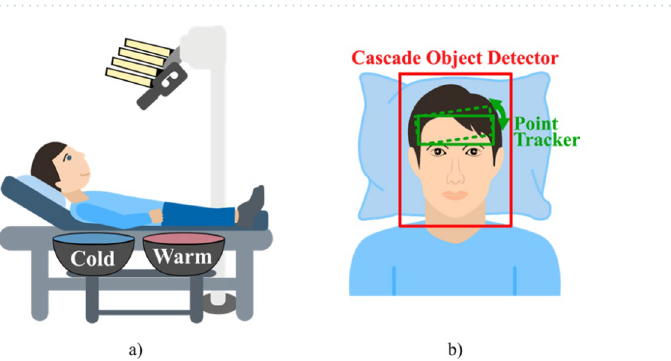
Figure 1. ( A ) Stages of the experimental protocol in the experimental group ( N = 13); with stages 3 and 5 being applied in reversed order in 3 recordings to randomize intervention. ( B ) Stages of the control group ( N = 3) with all stages using identical conditions.